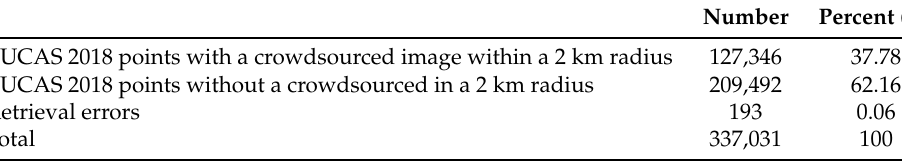
Table 2. Global density of LUCAS points with and without Mapillary crowdsourced images within a 2 km distance. The retrieval errors are mainly network errors due to server failures (502, 504).